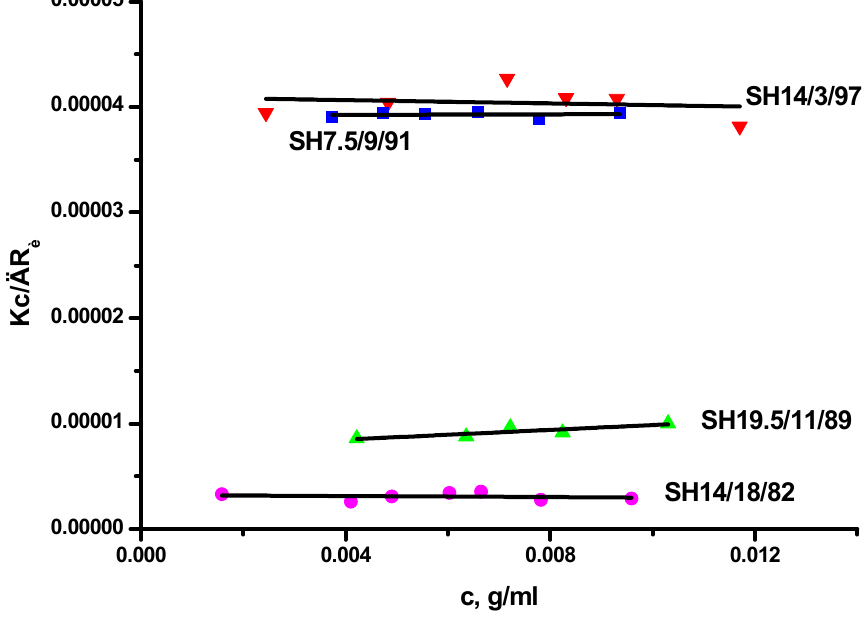
Figure 1. LALLS plots of SH block copolymers in n-heptane.